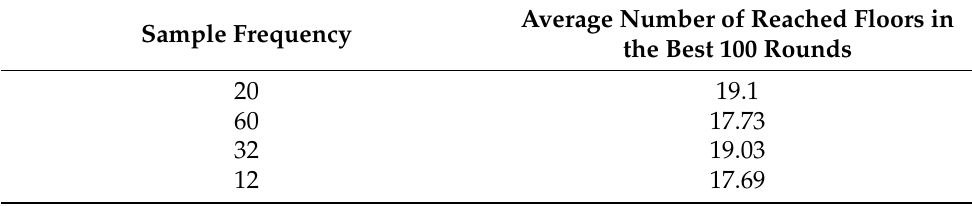
Table 8. Average number of reached floors in the best 100 rounds for 4 sample frequencies.